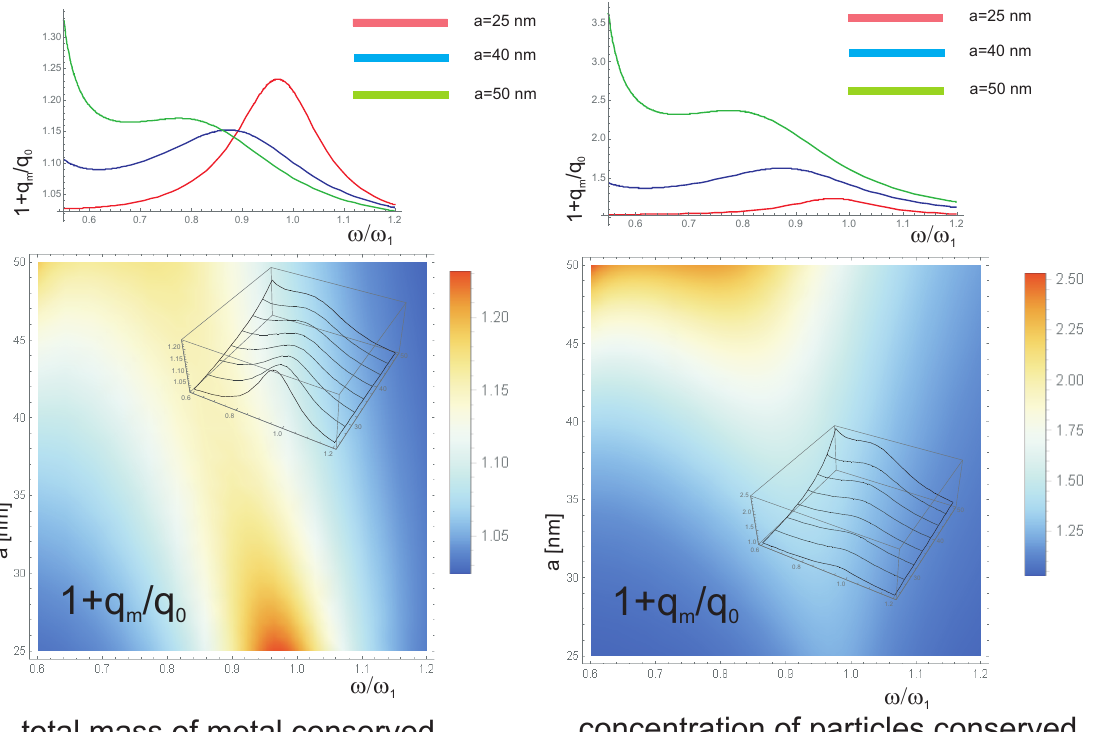
Figure 3. Size dependence of the photo-effect efficiency enhancement due to plasmon-mediation in light absorption, ( left ) for constant total mass of all metallic nanoparticles deposited on the semiconductor (Si) substrate and ( right ) for constant surface concentration of particles (the layer with the thickness H = 3 µ m, the proximity factor β = 0.0005, the density n s = 50 × 10 8 ( 25 and n s = 50 × 10 8 /cm 2 (right ), of Au nanoparticles with radius a ∈ ( 25,50 ) nm). The red shift with the nanoparticle size growth is noticeable. The efficiency increase I / I 0 = 1 + q m / q 0 (cf. Equations (19) and (18)) depends on the metallic nanoparticle size, material metal and semiconductor parameters and on the density of the metallic coverage ( ω is the frequency of the incident light in dimensional units, i.e., divided by ω 1